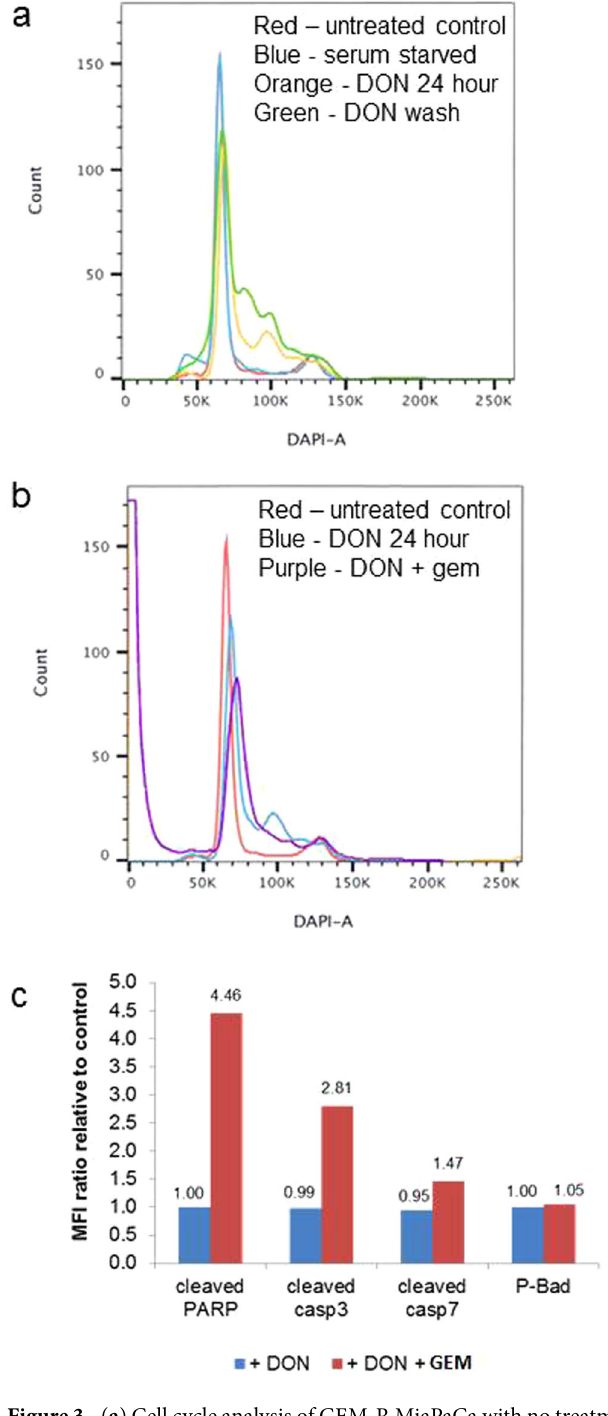
Figure 3. ( a ) Cell cycle analysis of GEM-R MiaPaCa with no treatment (control), incubation with 50 mM DON for 24 hours, exposure to 50 mM DON for 24 hours followed by media change and growth for 24 hours (DON washout). Note the transient G1/S phase block which was reversible following change to fresh media. ( b ) Cell cycle analysis of GEM-R MiaPaCa with no treatment (control), incubation with 50 mM DON for 24 hours, exposure to 50 mM DON for 24 hours followed by 72 hours treatment with GEM. Note the prominent apoptotic peak in the cells treated with DON followed by GEM (purple). ( c ) Multiplex bead based analysis of apoptotic markers, including cleaved PARP, cleaved caspase 3, cleaved caspase 7, and P-Bad, on GEM-R MiaPaCa with incubation with 50 mM DON for 24 hours, sequential DON and GEM treatment using untreated cells (control) as a